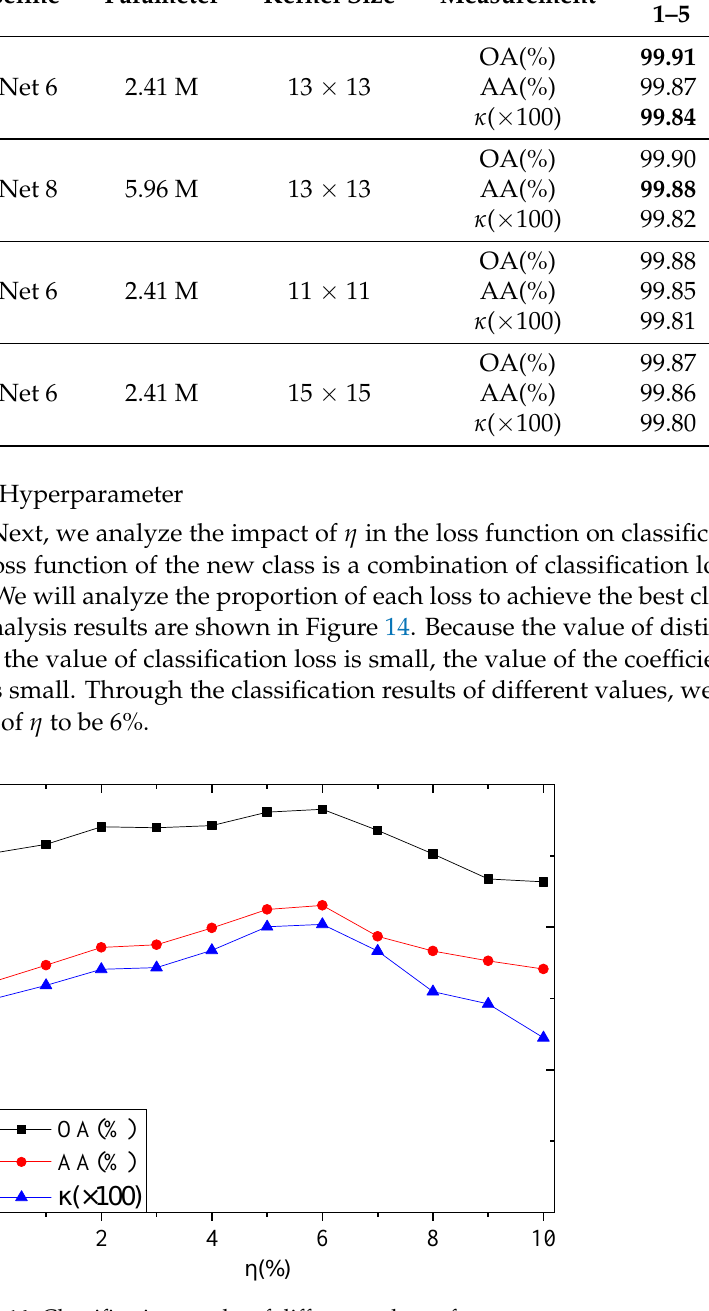
Figure 14. Classification results of different values of η